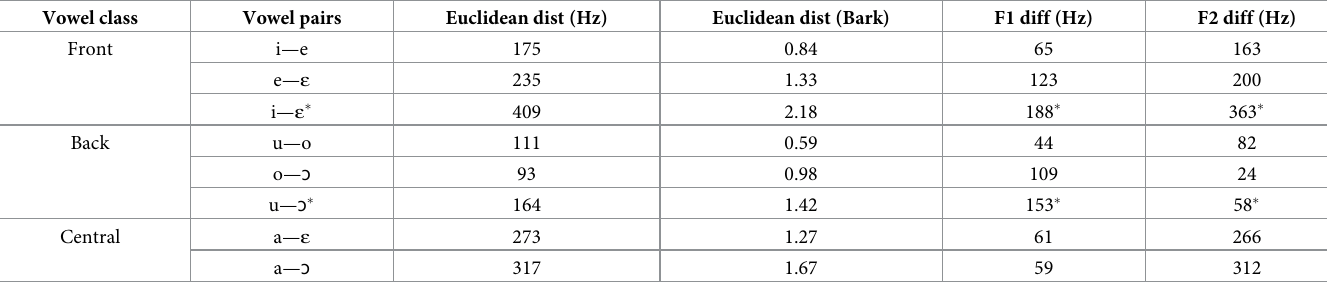
Table 6. Intervocalic Euclidean distances and mean F1-F2 values between phonetic vowels. Vowel